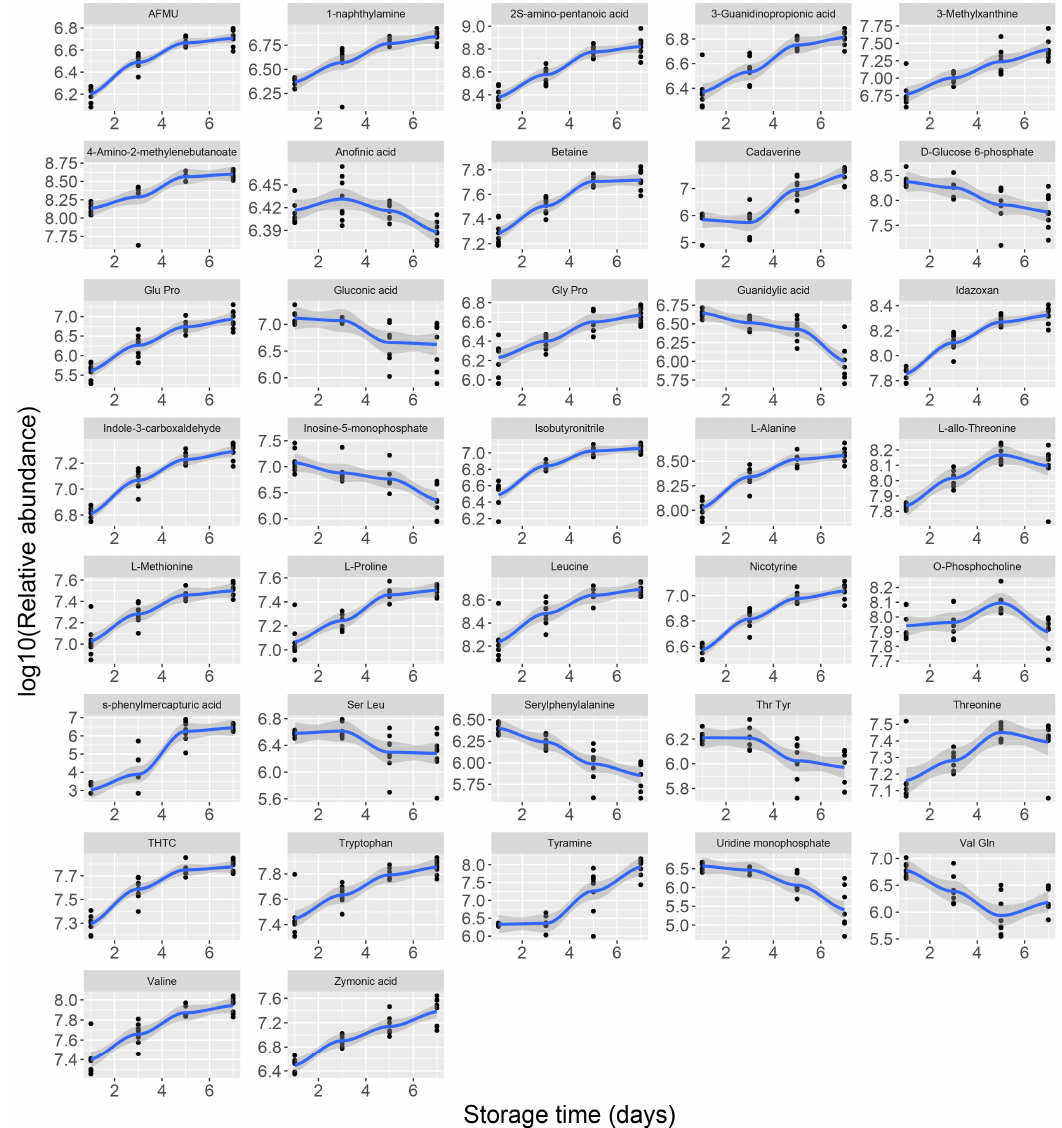
Figure 4. Profile analysis of potential biomarkers identified by using the random forest model.